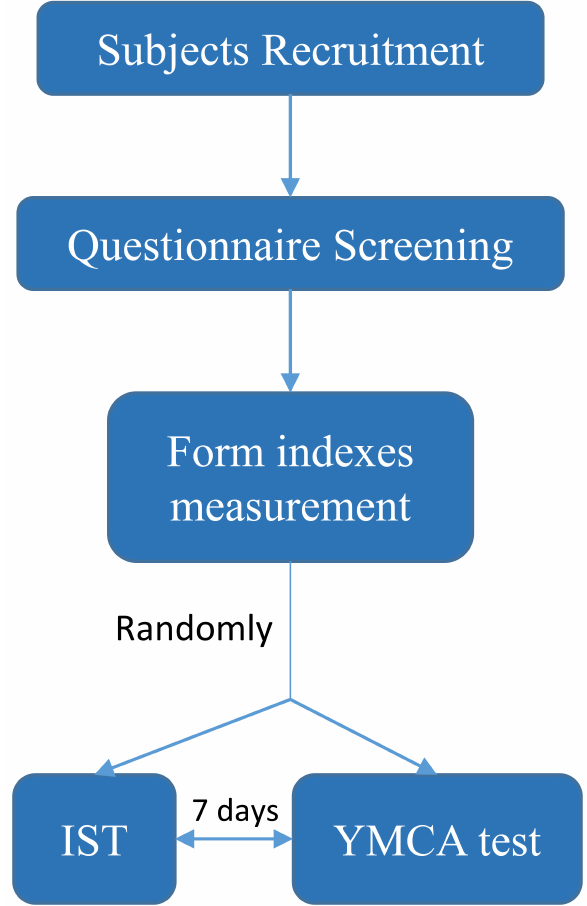
Fig. 2. All subjects need to take part in two tests (IST and YMCA